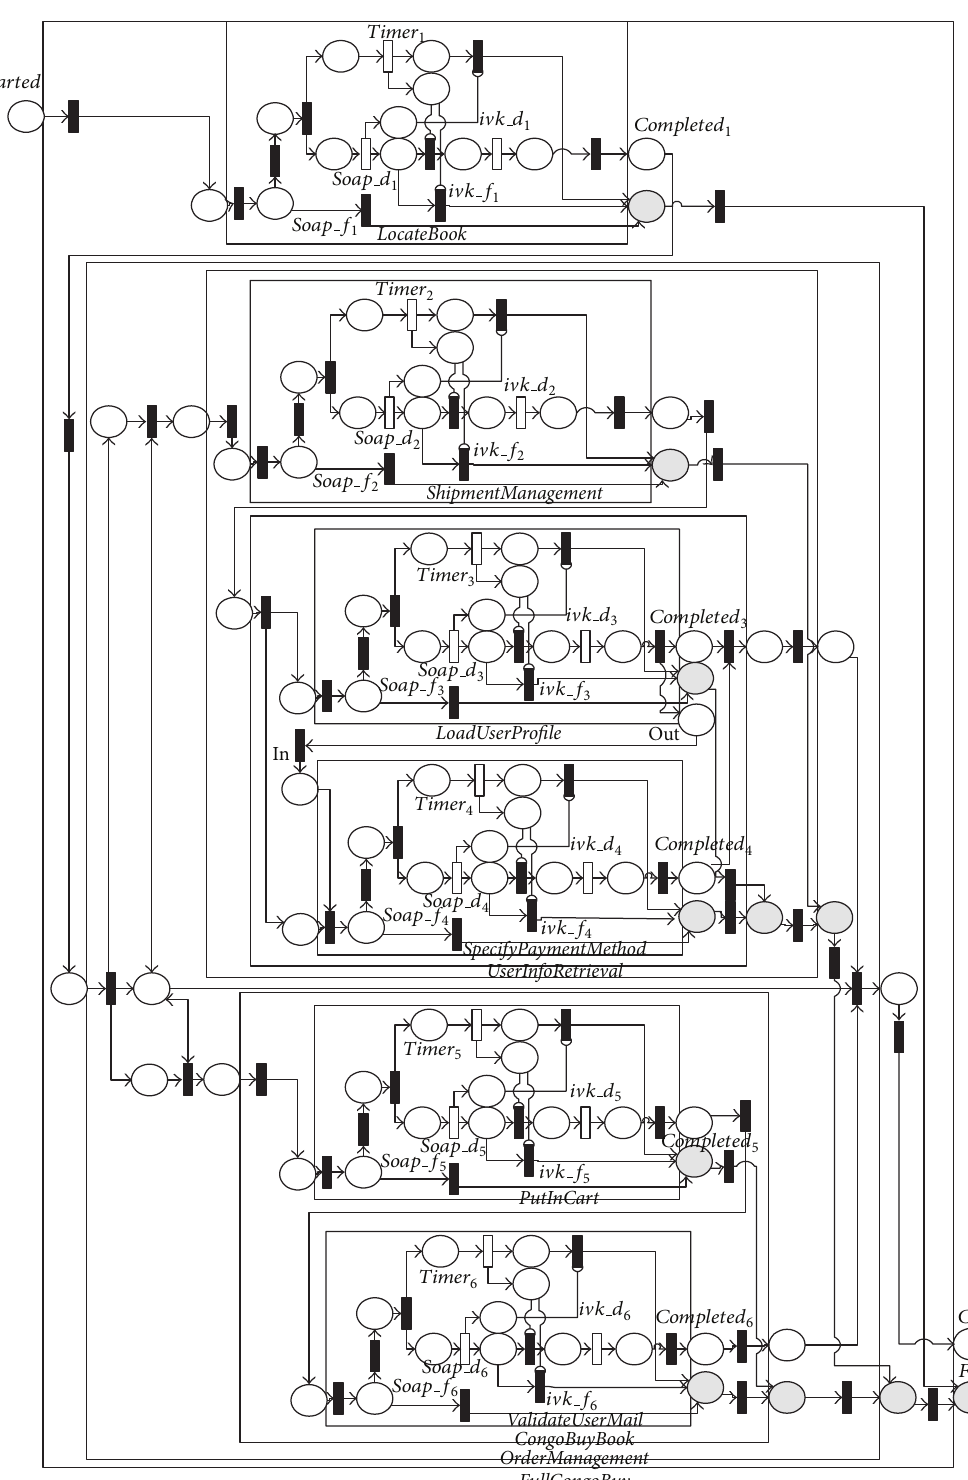
Figure 10: NMSPN model of the any-order